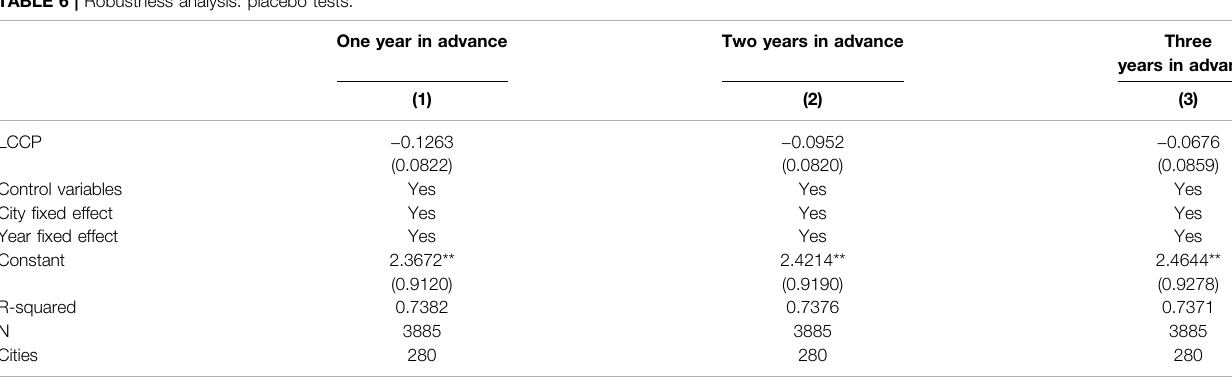
TABLE 6 | Robustness analysis: placebo tests.